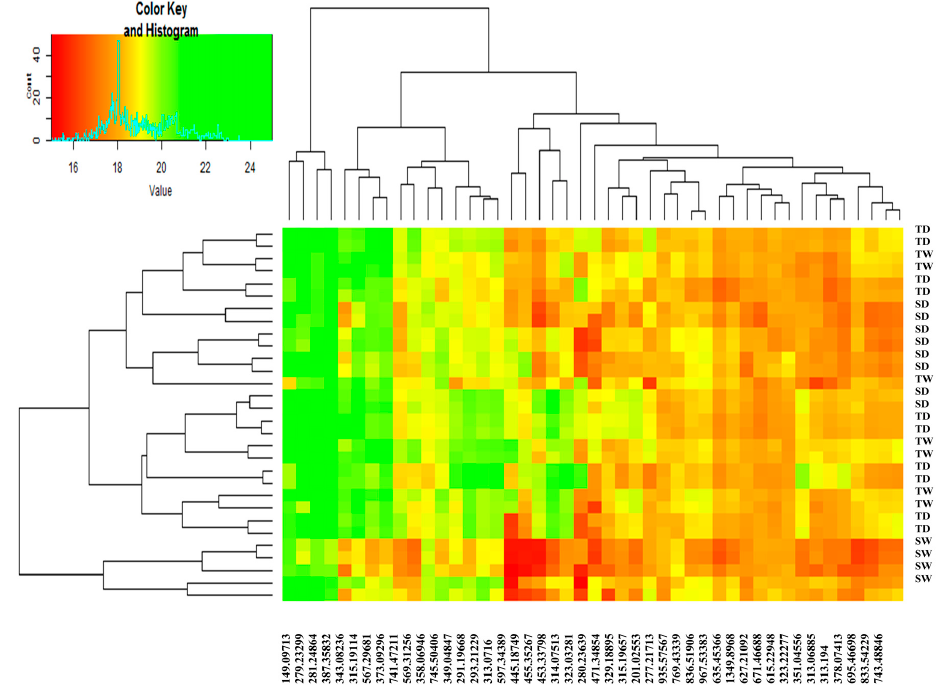
Figure 6. Hierarchically clustered heat map of the data. Forty-five peaks were divided into four groups (SD, sensitive drought-stressed; SW, sensitive watered; TD, tolerant drought-stressed; TW: tolerant watered). Different colors indicate the relative abundance of each metabolite in different conditions.